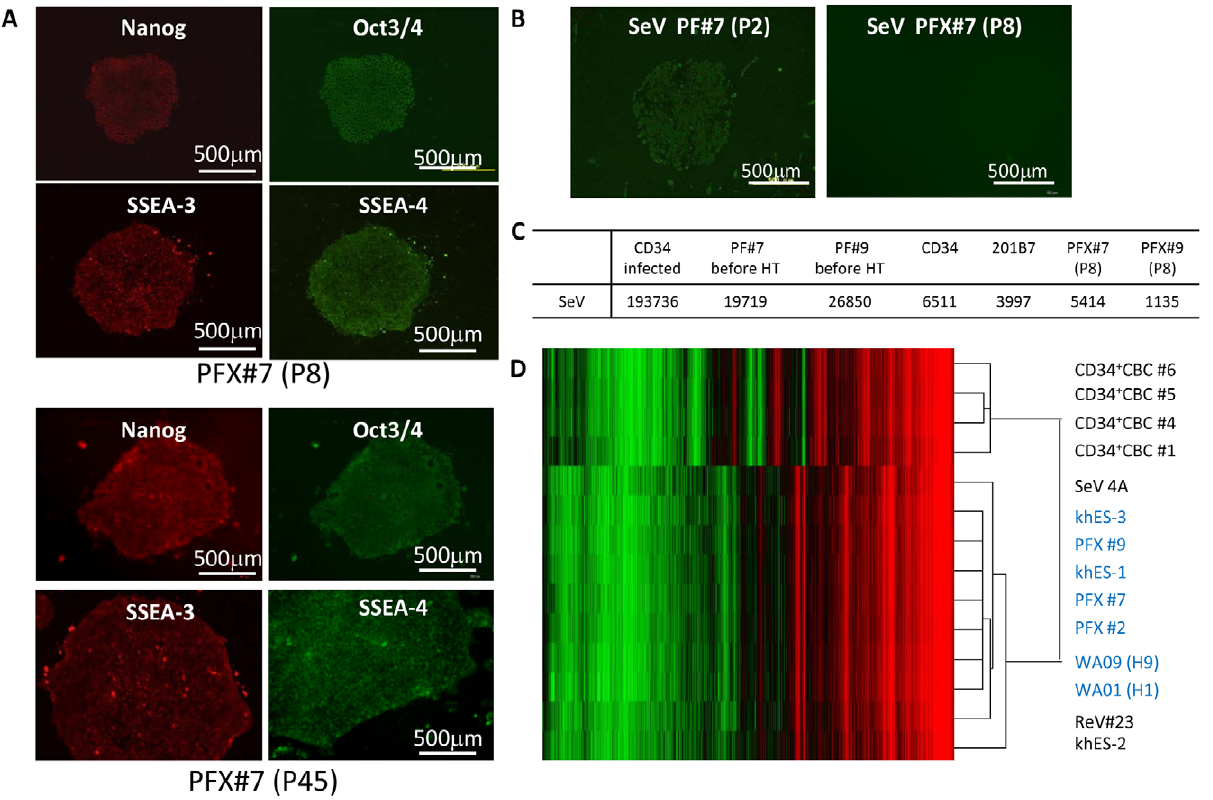
Figure 4. Characterization of single cell-derived reprogrammed clones. (A) Expression of pluripotency-related molecules in reprogrammed cell clones. ES cell-like clone PFX # 7 at P8 (upper panels) and at P45 (lower panels) was stained with antibodies against Nanog, Oct3/4, SSEA-3, or SSEA-4 as indicated. Alexa 594- and Alexa 488-conjugated secondary antibodies (red and green, respectively) were used to visualize the staining. (B) Expression of SeV in ES cell-like colonies before heat treatment at passage two (SeV at P2) and after heat treatment and single cell cloning at passage eight (SeV at P8, PFX # 7). The SeV construct was determined by immunostaining with antibody against SeV HN. (C) Quantitative RT-PCR determination of residual SeV viral genomes in CD34 + CBCs three days after SeV infection (CD34 infected), first primed colony iPS # 7 or iPS # 9 before heat treatment at P2 (iPS # 7 before HT, TS # 9 before HT), non-infected CD34 + CBCs (CD34) or iPSC clone generated by retrovirus (201B7), established clones at P9 (PFX # 7) or (PFX # 9). Values were normalized using the housekeeping gene GAPDH . (D) Heat map for gene expression of CD34 + CBCs lots # 1, # 4, # 5, # 6, established clones PFX # 2, # 7, # 9 at P22, human ES cell lines (khES-1, khES-2, khES-3 at P15 (as obtained), WA01 (H1), and WA09 (H9) at P16 (as obtained) on SNL, iPSC generated from CD34 + CBC by temperature non-sensitive SeV (SeV # 4A) at P18 and by retrovirus (ReV # 23) at